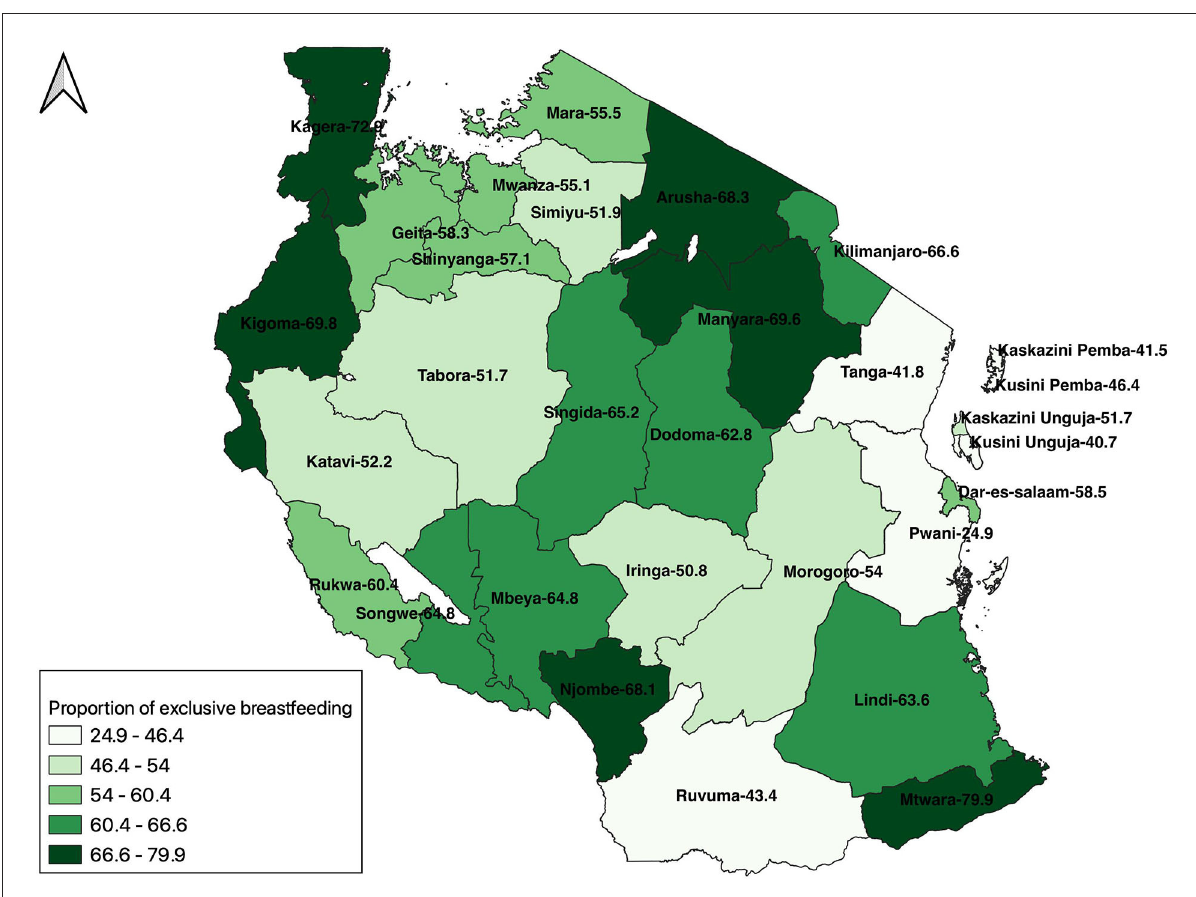
FIGURE2 A map of the proportion of exclusive breastfeeding in Tanzania,